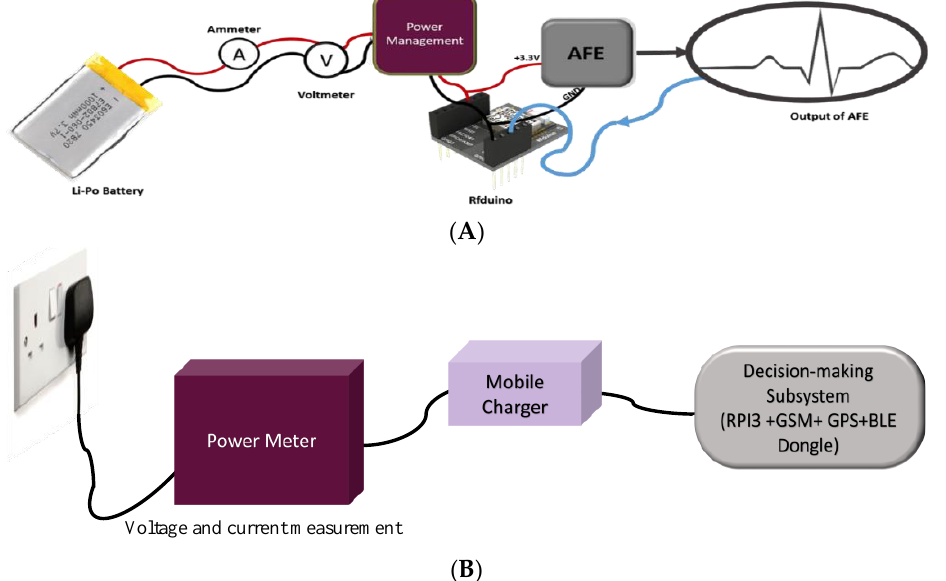
Figure 6. Set-up of power consumption study for wearable subsystem ( A ) and decision-making subsystem ( B ).